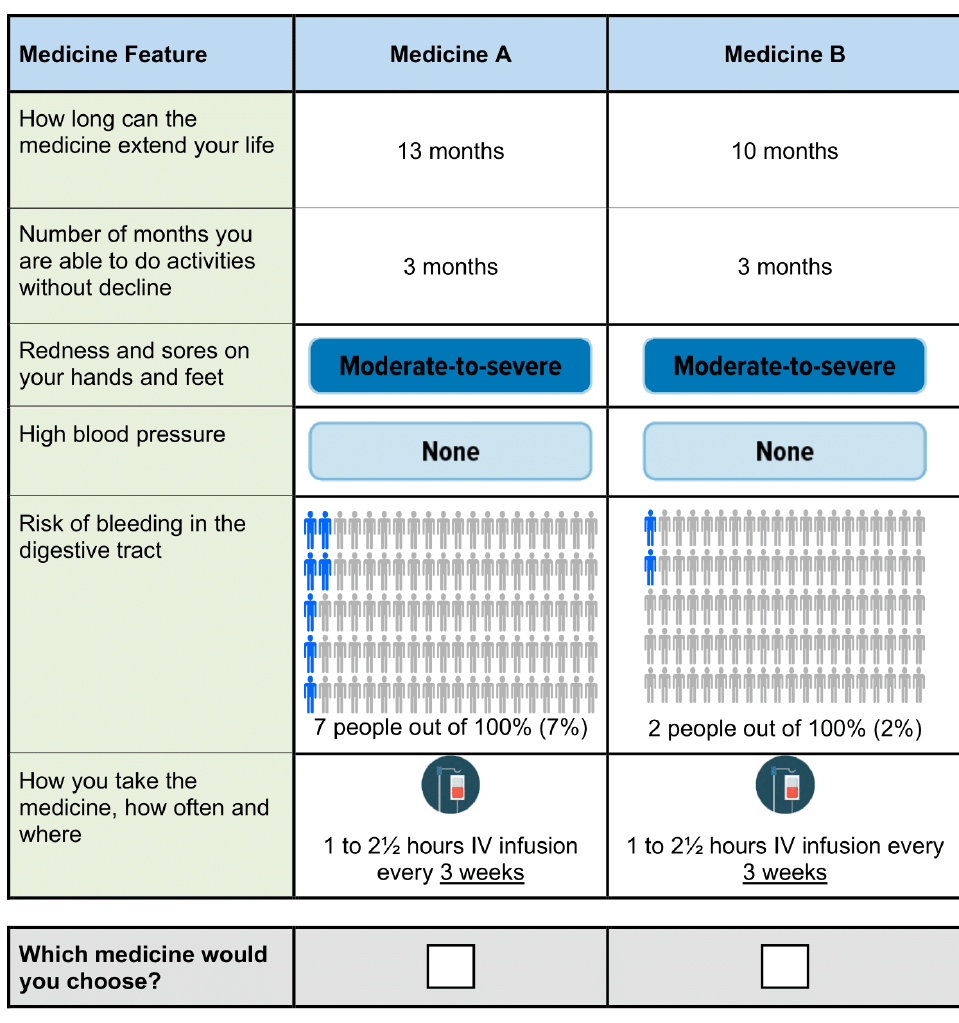
Figure 1. Example discrete-choice experiment question.